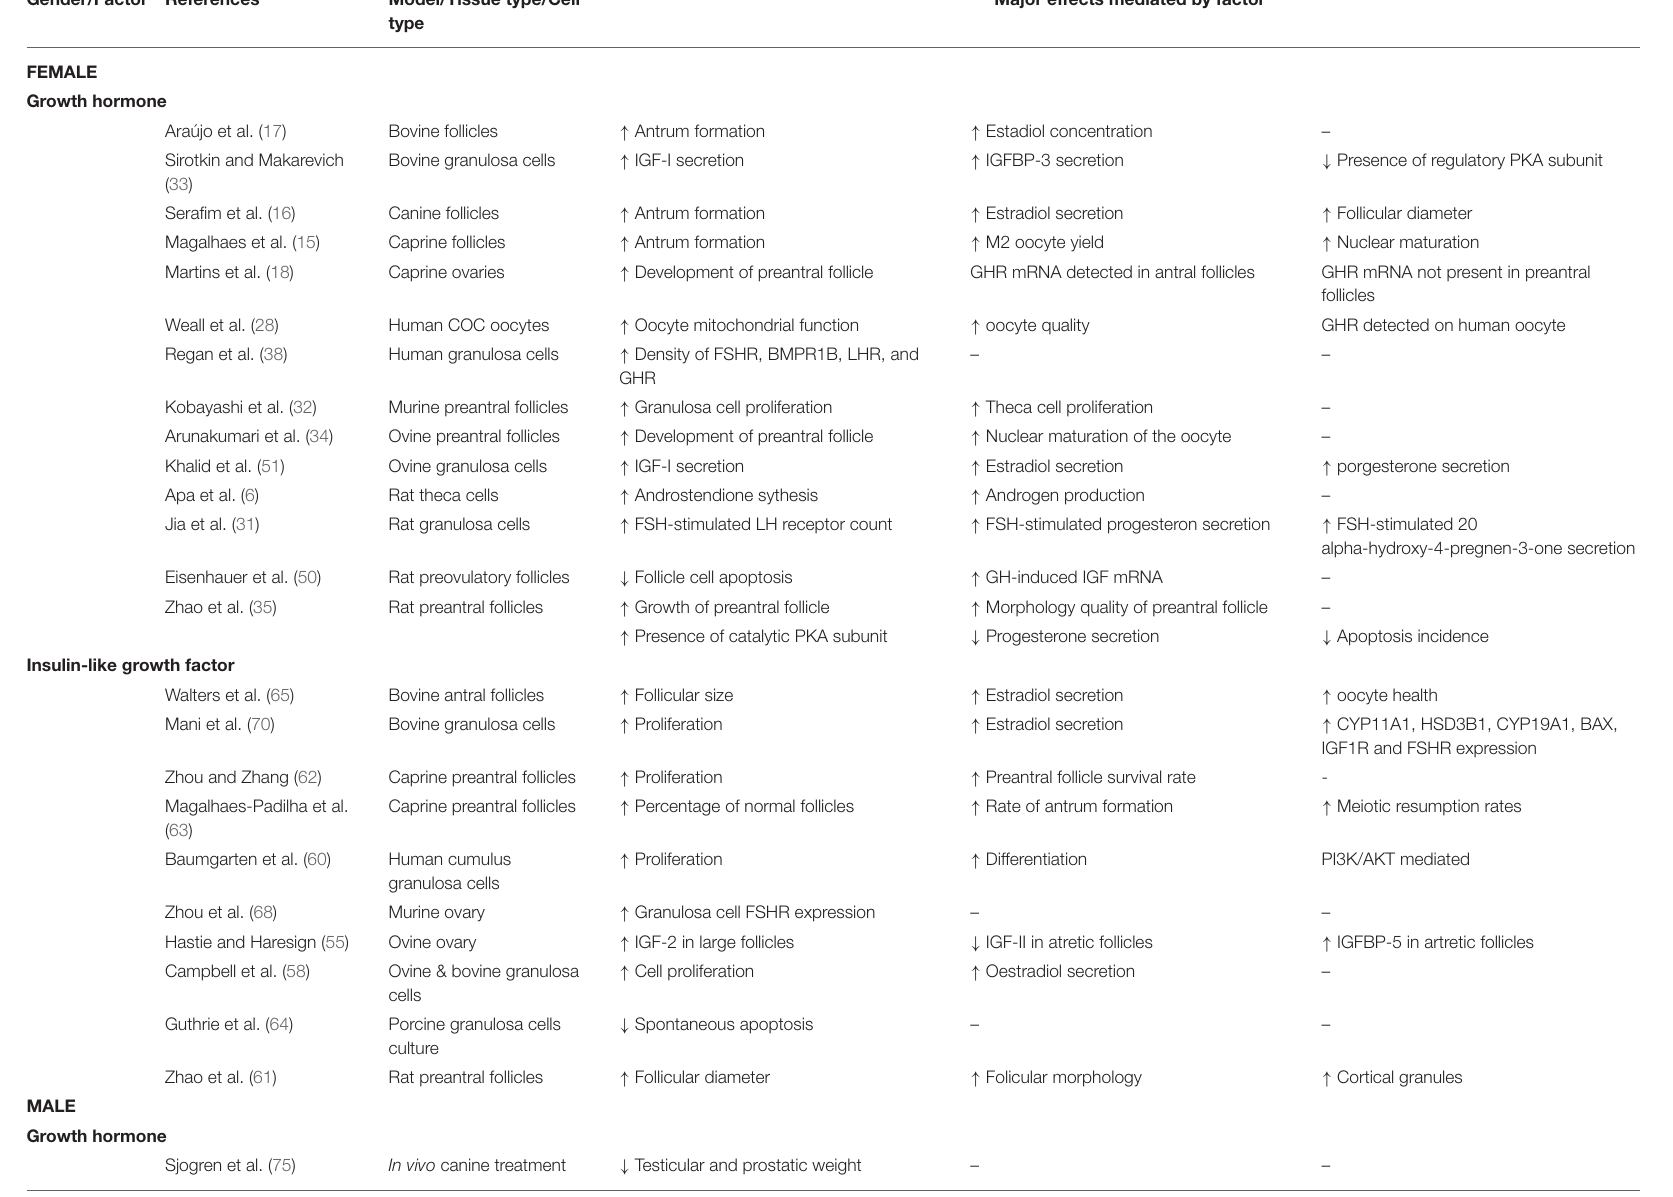
TABLE 1 | Summary of major findings from GH and IGF studies in ovarian and testicular